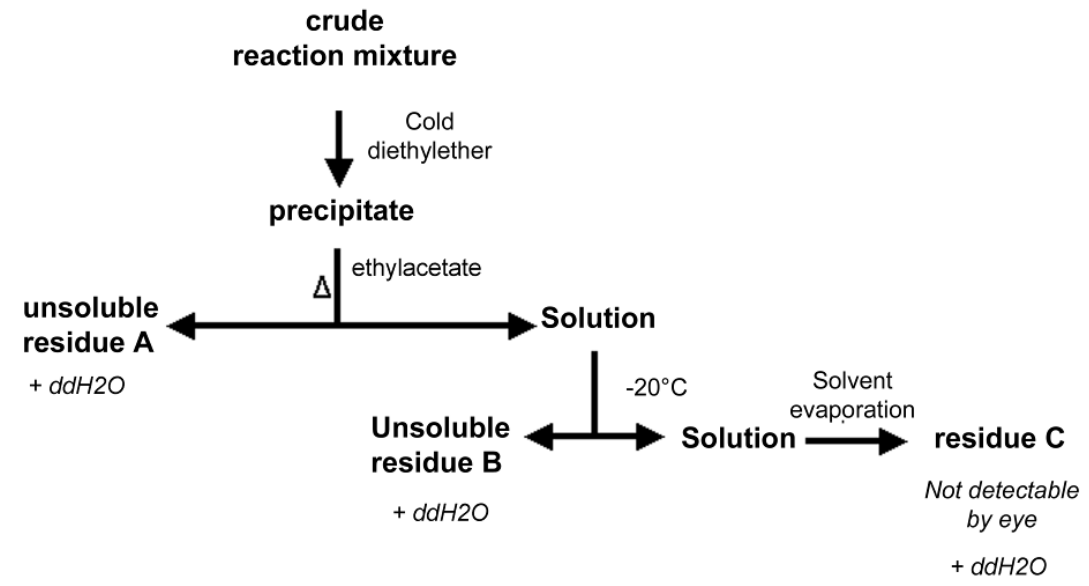
Figure 2. The differential solvent extraction process